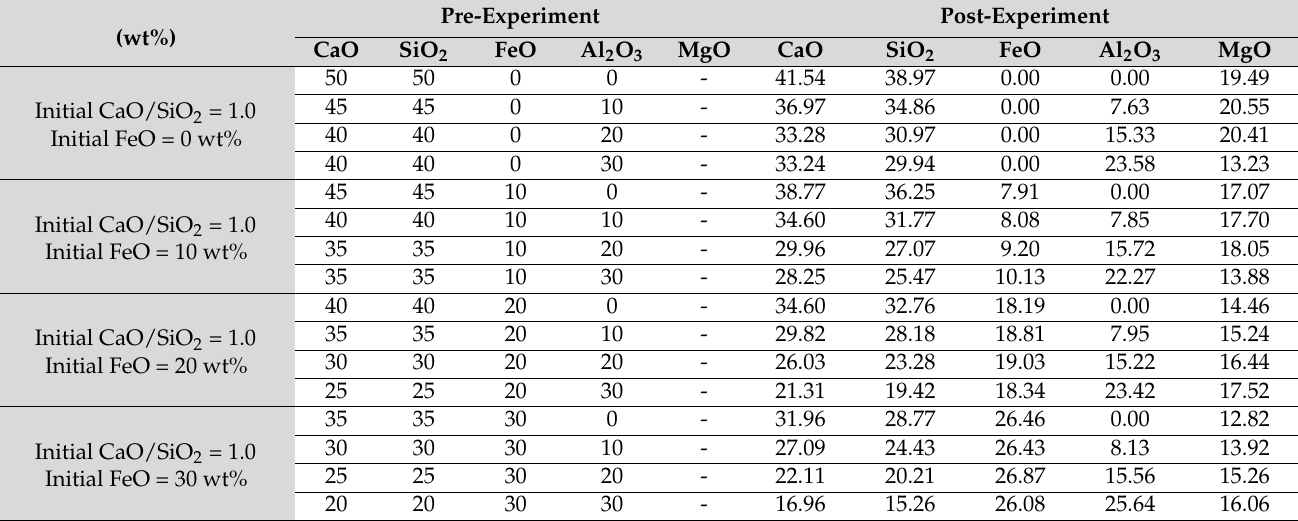
Table 1. Experimental results of MgO solubility for CaO–SiO 2 –FeO–Al 2 O 3 slags at 1823 K.